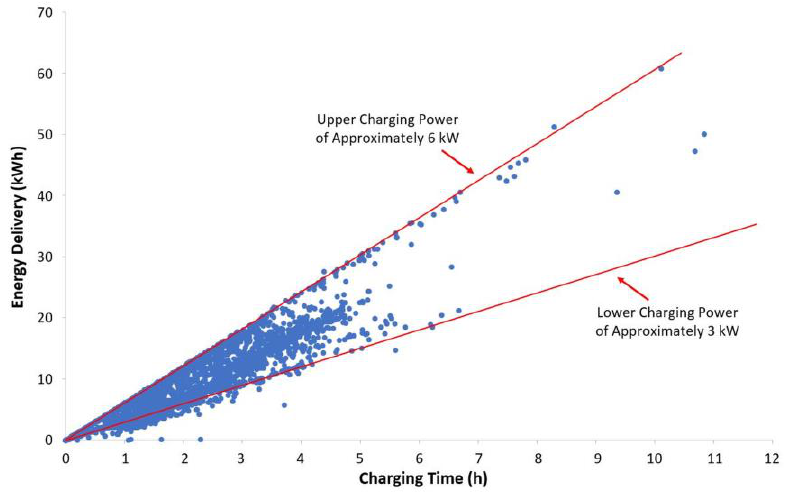
Figure 4. Energy delivery versus charging time for each charging event.